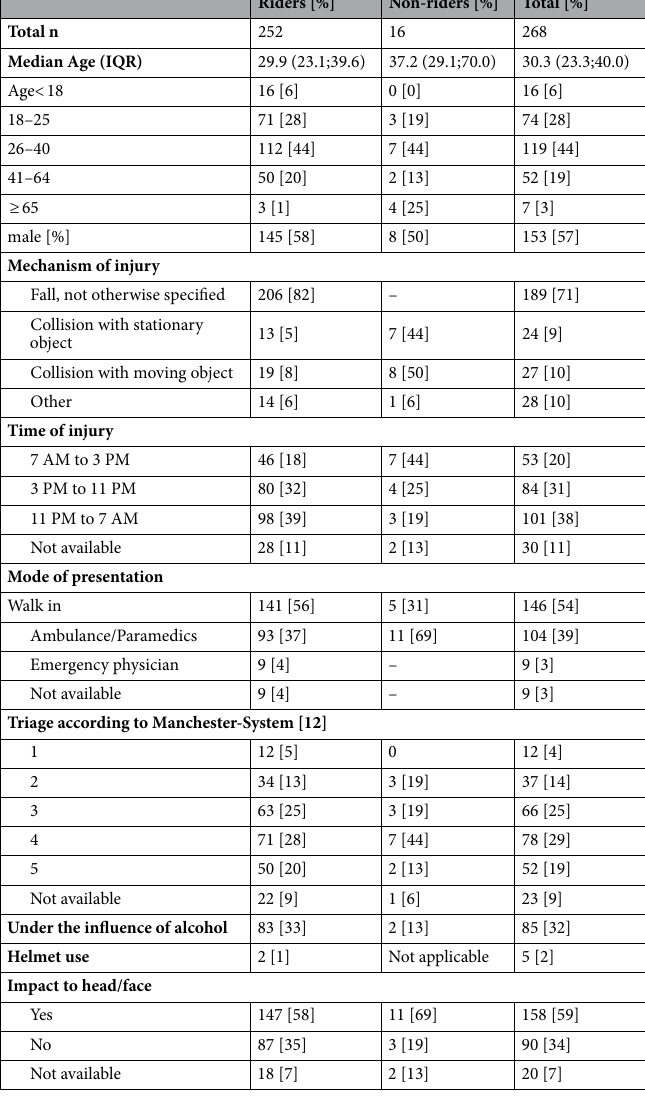
Table 1. Epidemiology, mechanism and cause of injury and mode of presentation of e-scooter riders and non- e-scooter riders.